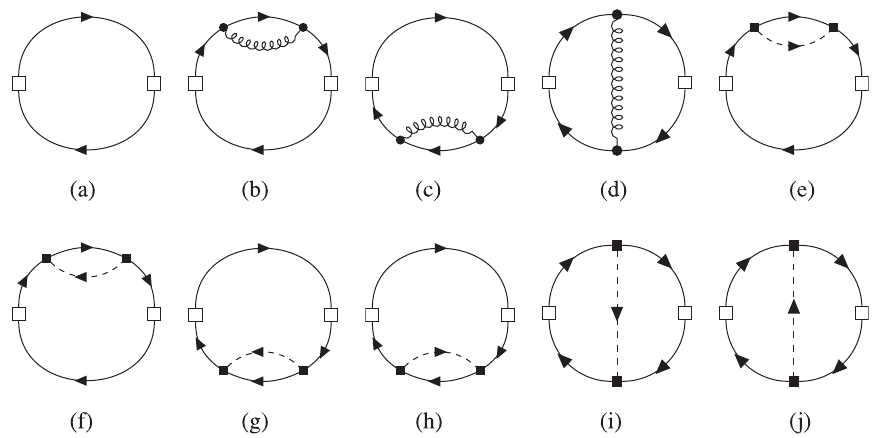
FIG. 7. Diagrams contributing to the numerator N 2 [Eq. (B32)] of h O 2 i ¼ h c ð τ Þ c † ð 0 Þi . Here, conventions are as in Fig. 5, and an open square denotes the external c=c †